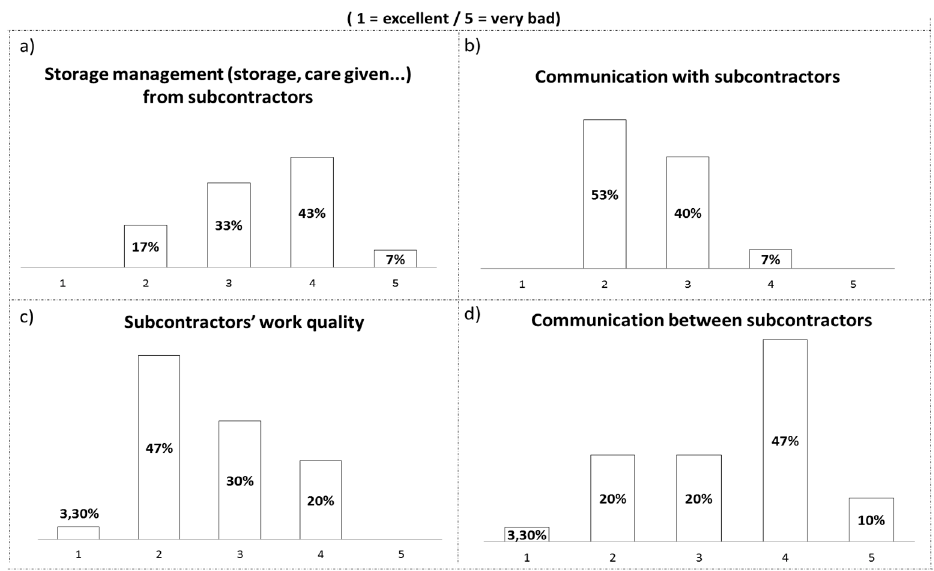
Figure 9b: The quality of communication with subcontractors seemed decent overall, indicating Figure 9c: On average, the quality of subcontractors’ work is perceived as